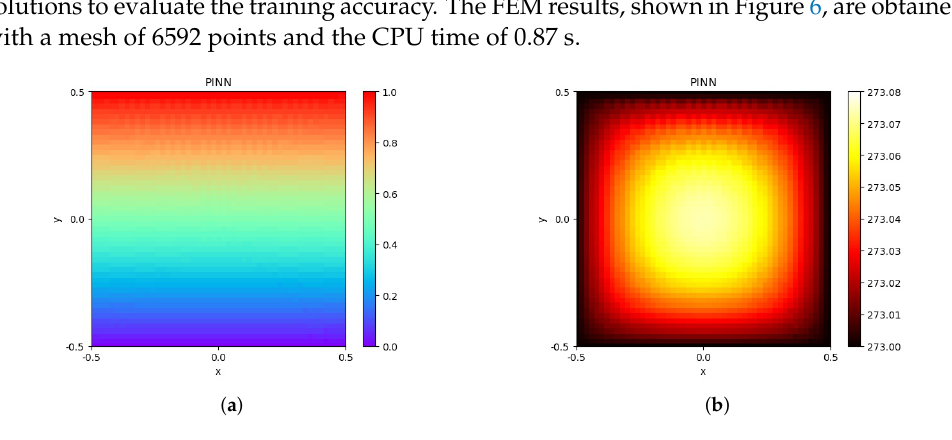
Figure 5. Results of our PINN networks: ( a ) the electric potential (V); ( b ) the temperature (K).